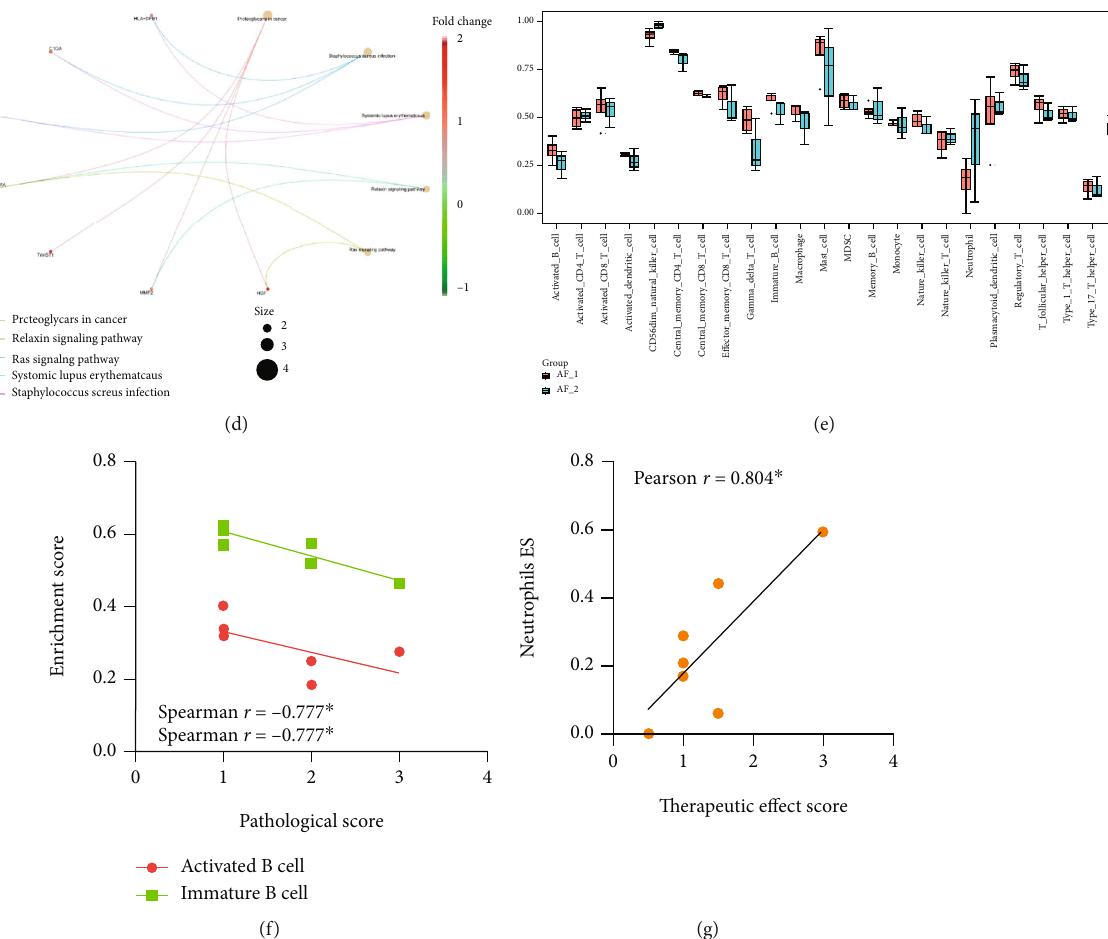
Figure 4: Identi fi cation of di ff erentially expressed immune-related genes related to e ffi cacy after neoadjuvant therapy. Seven cases of bladder cancer tissues after neoadjuvant chemotherapy were divided into the favorable prognosis group ( n = 3 ) and the poor prognosis group ( n = 4 ) according to the fi nal curative e ff ect. (a) Heatmap showing the di ff erentially expressed genes with signi fi cant fold change. (b) Bar plot showing the di ff erentially expressed genes with signi fi cant fold change. (c) Gene ontology (GO) analysis. (d) Kyoto Encyclopedia of Genes and Genomes (KEGG) analysis. (e) Bar plot showing immune in fi ltration genes analyzed by single-sample gene set enrichment analysis (ssGSEA). (f) The Spearman correlation analysis between pathological score and activated/immature B cell. (g) The Pearson correlation analysis between therapeutic e ff ect score and neutrophil. P values in the (a), (b), and (e) sub fi gures were calculated by the Wilcoxon rank-sum test (two-tailed). The P values in the (f) and (g) sub fi gure were calculated by Spearman correlation analysis and Pearson correlation analysis, respectively. Di ff erences were found to be statistically signi fi cant at ∗ P < 0 : 05